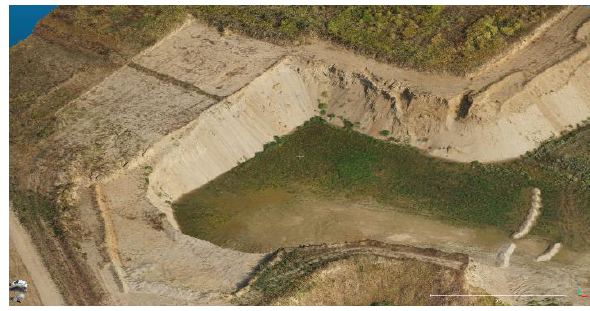
Figure 1. Overview of the testsite